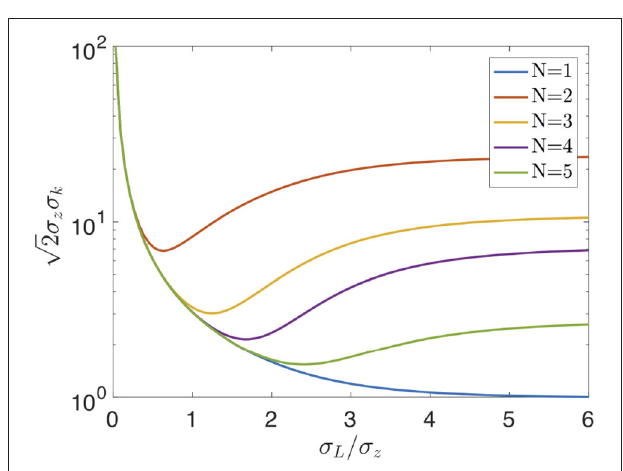
FIGURE 7 | Scaled bunching bandwidth vs. relative laser duration for phase distortions of φ N σ N z 20 caused by different orders. Harmonic m = 50 is =